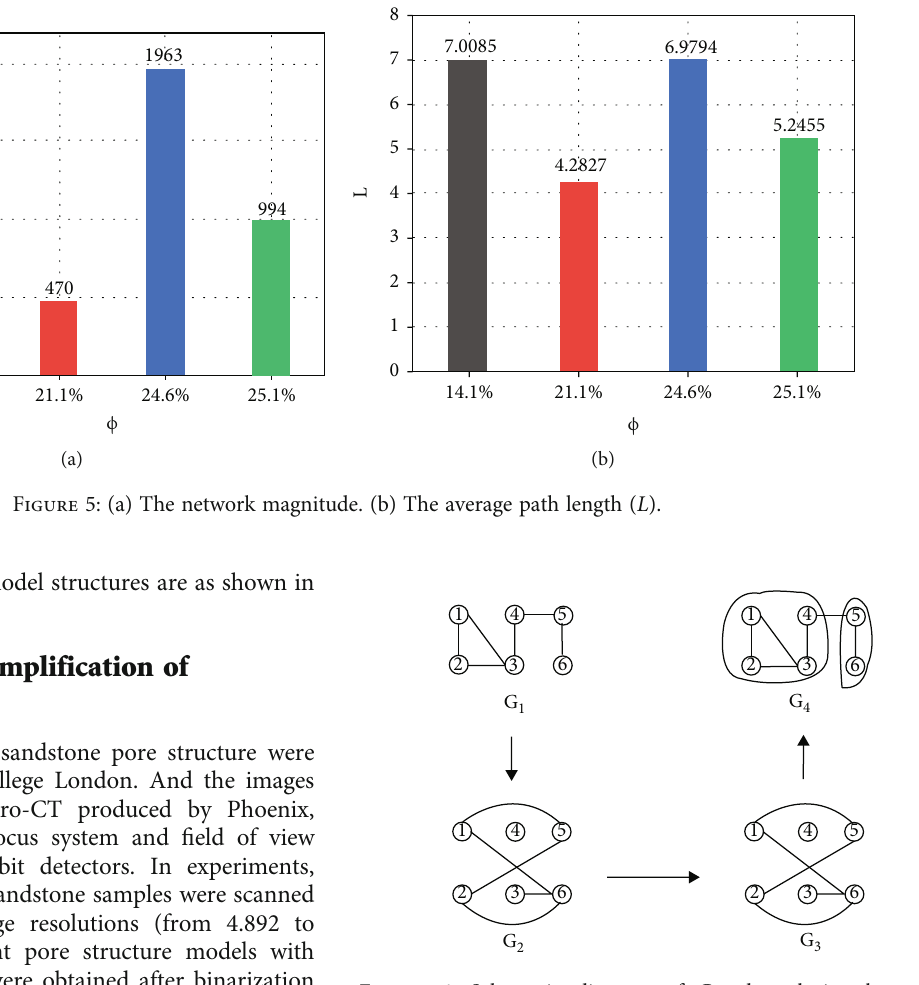
Figure 6: Schematic diagram of Greedy coloring box cover algorithm ( l B = 3